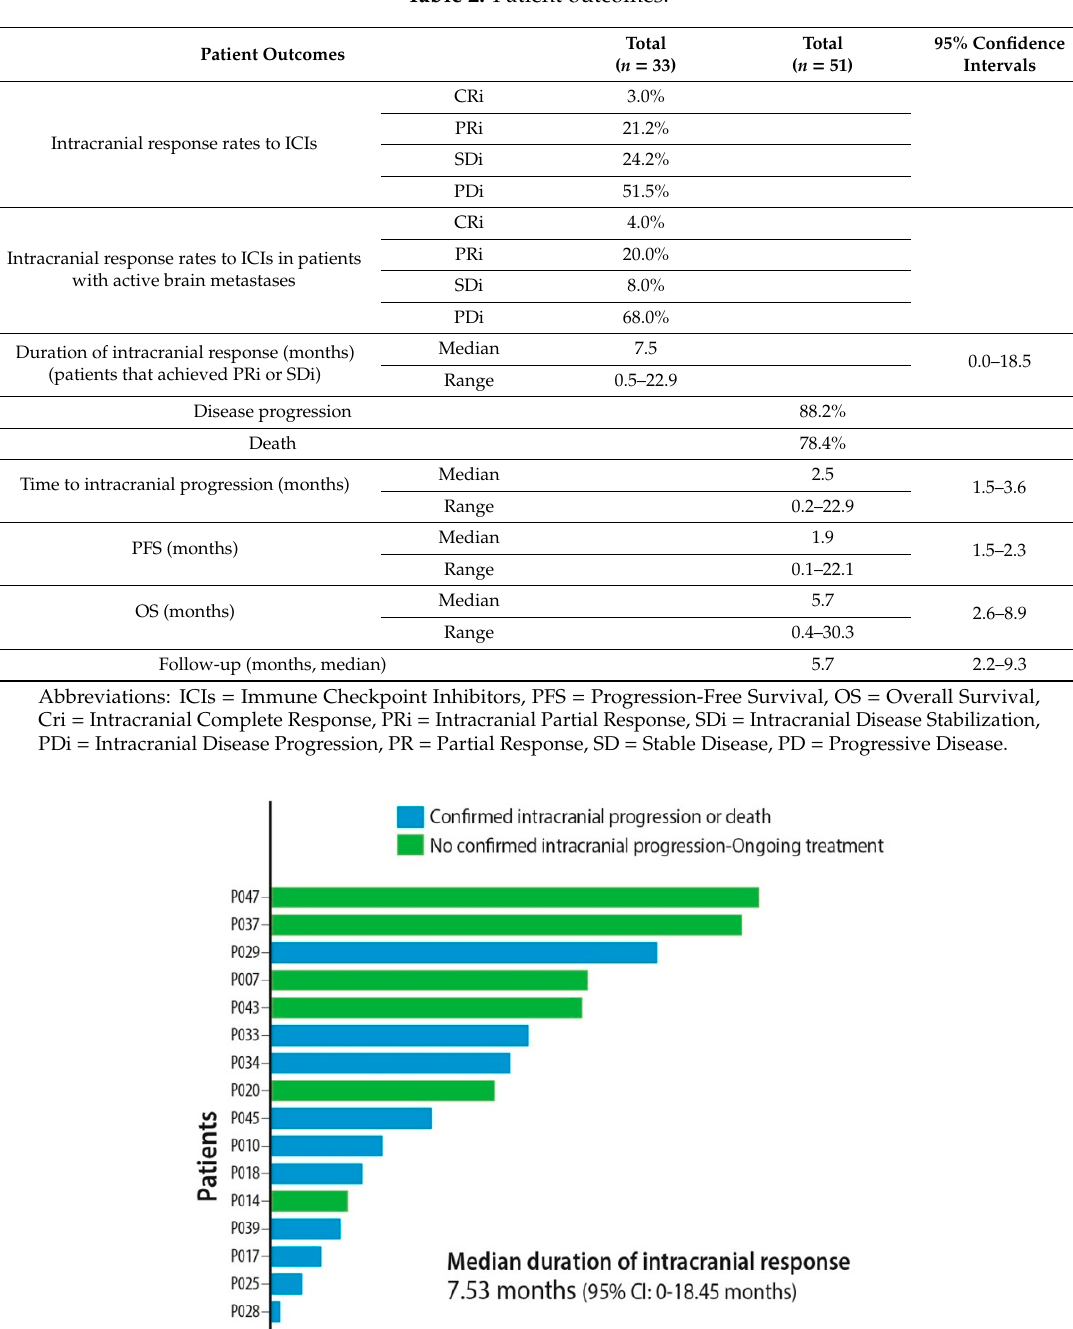
Table 2. Patient outcomes.